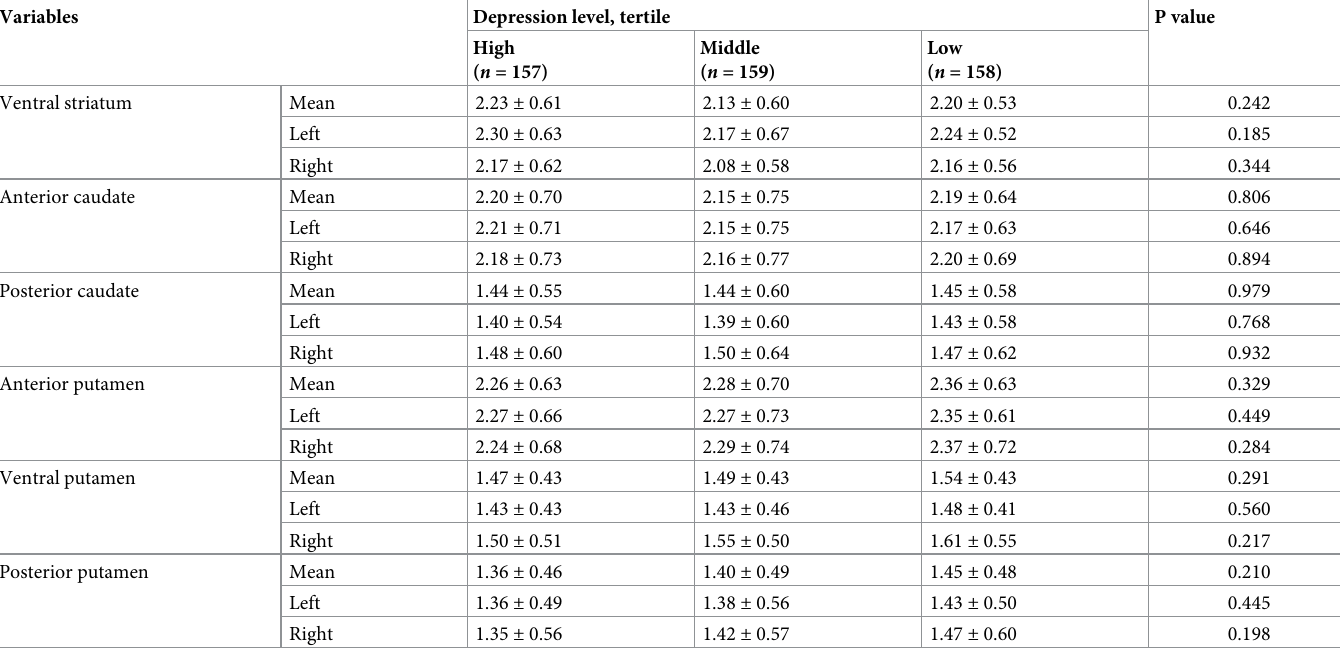
Table 2. Dopamine transporter binding in striatal subregions.